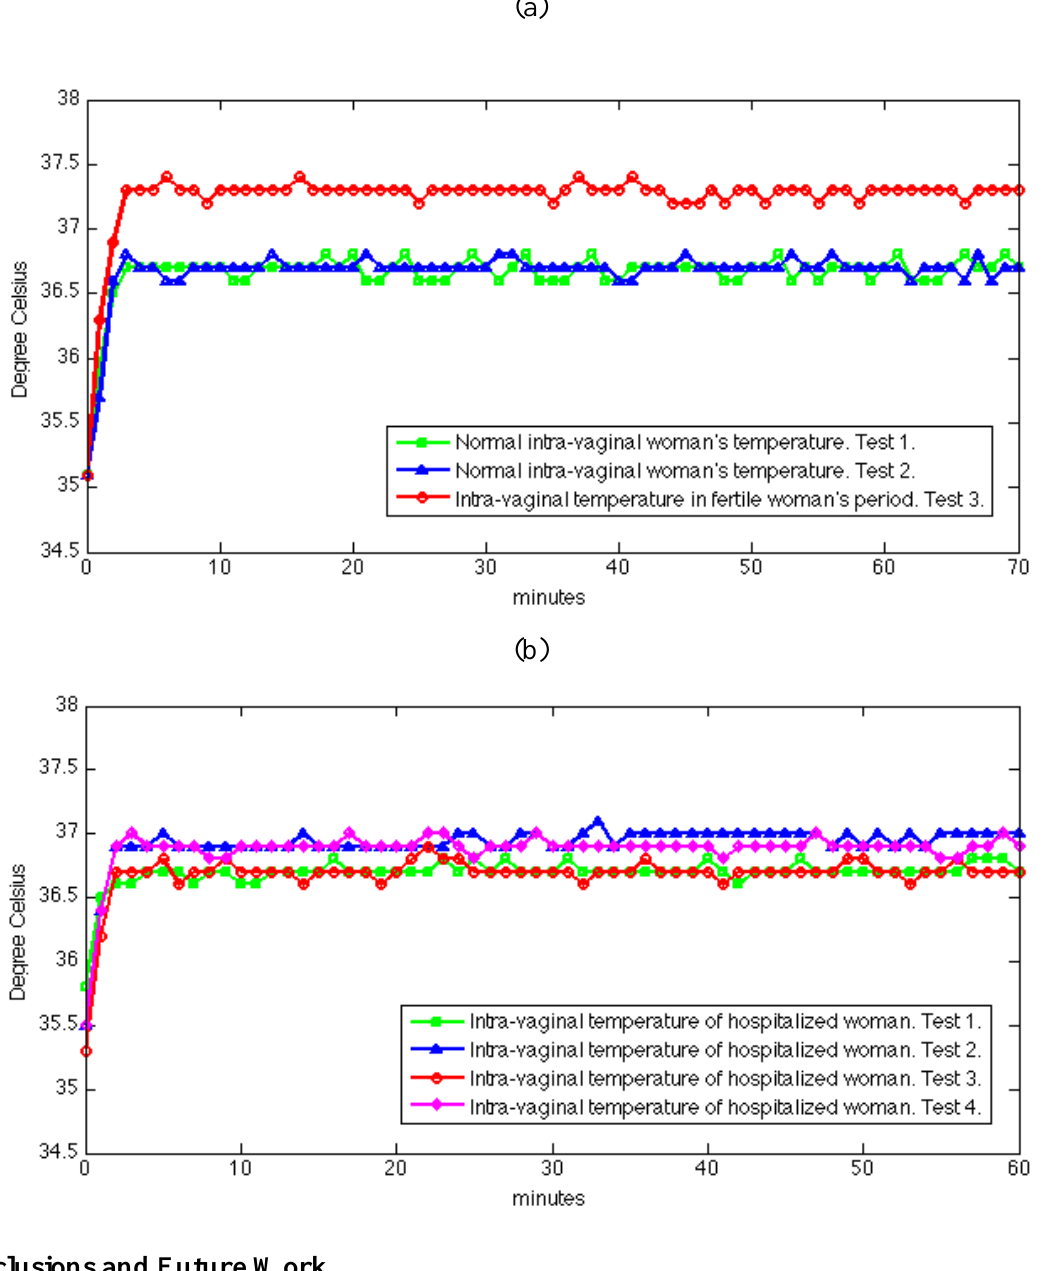
Figure 6. (a) Samples of performed tests in day life woman. (b) Samples of performed tests in hospitalized